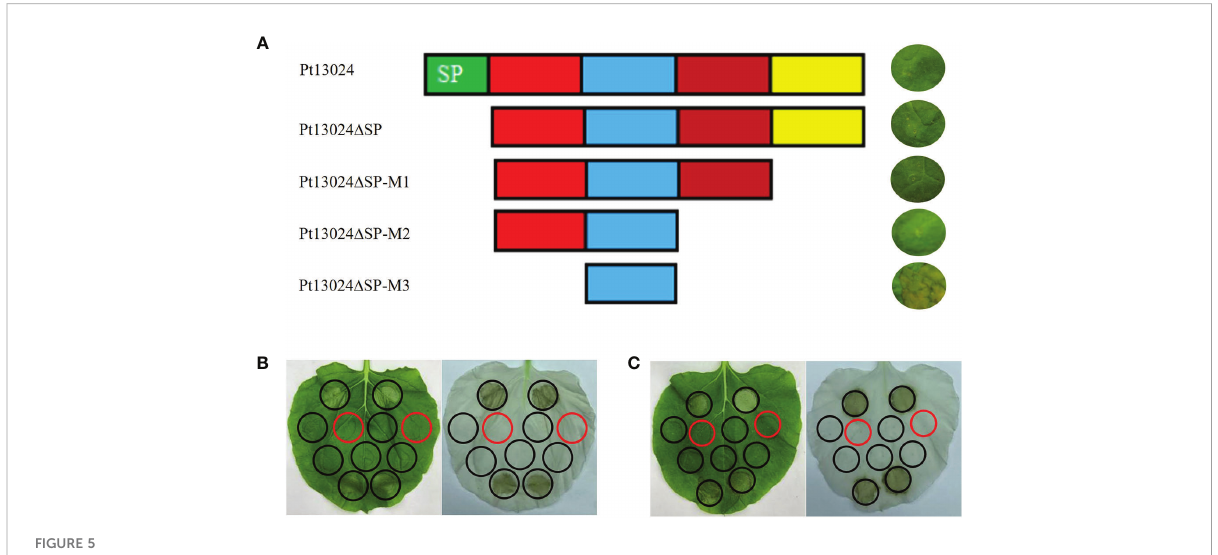
FIGURE 5 Analysis of the Pt13024 region required for the suppression of PCD. (A) The mutants of Pt13024 were constructed and veri fi ed on N. benthamiana. The toxicity domain of Pt13024 was in the amino acids 22 to 41 at the N-terminal. (B) Pt13024 in 09-12-284-1 inhibited PCD induced by BAX and INF1 effectively. On the right is the decolorized phenotype of treated leaf. (C) Pt13024 in 03-5-99 strain inhibited PCD induced by BAX and INF1 effectively. On the right is the decolorized phenotype. The in fi ltration pattern diagram is same as that in Figure 4A. aa, amino acid; BAX, Bcl-2-associated X protein; PCD, programmed cell